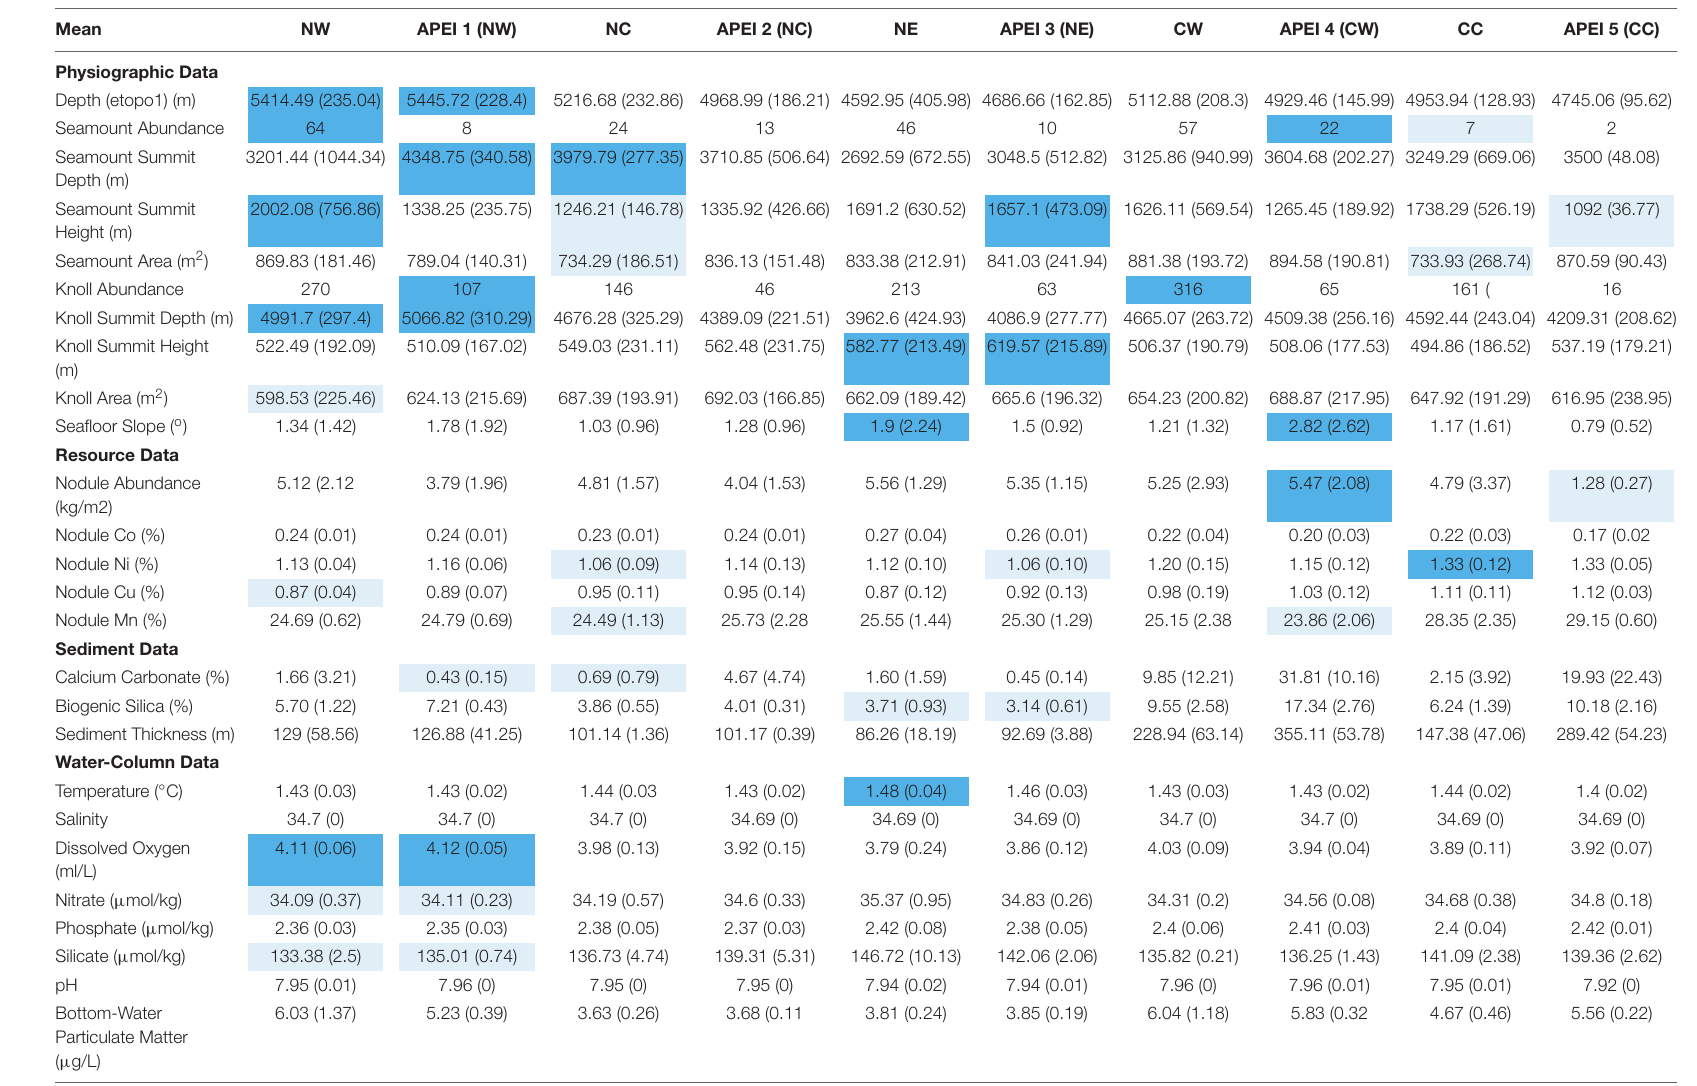
TABLE 1 | The mean (standard deviation) of environmental variables in each CCZ subregion and APEI.